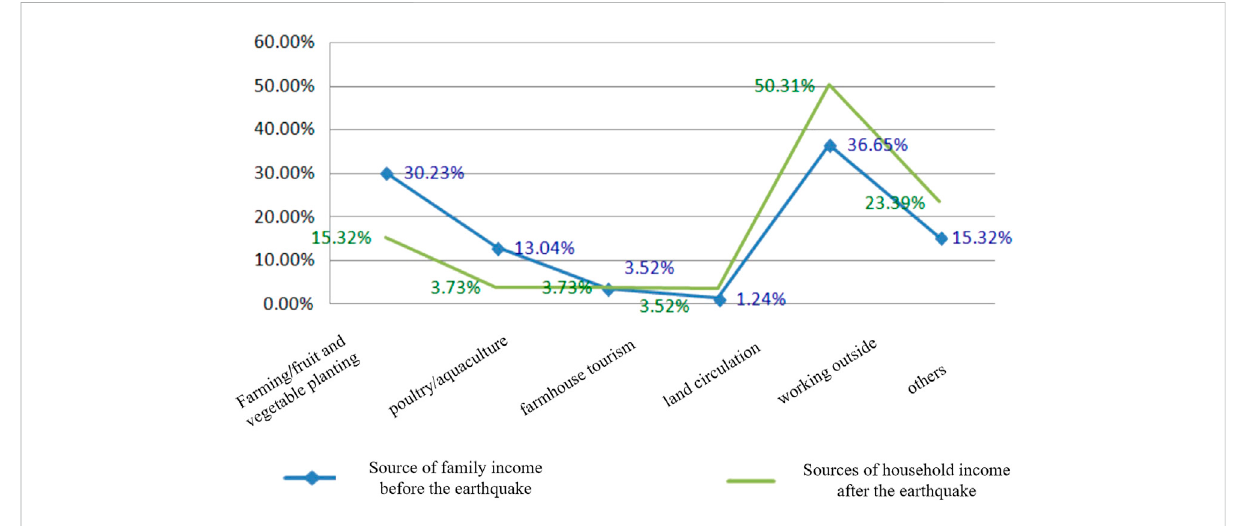
FIGURE 3 Major sources of income for households before and after the